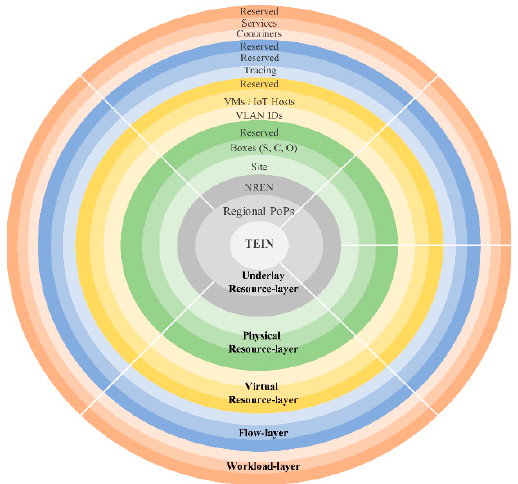
Figure 10. Multi-belt onion-ring visualization to show multi-layer visibility data.